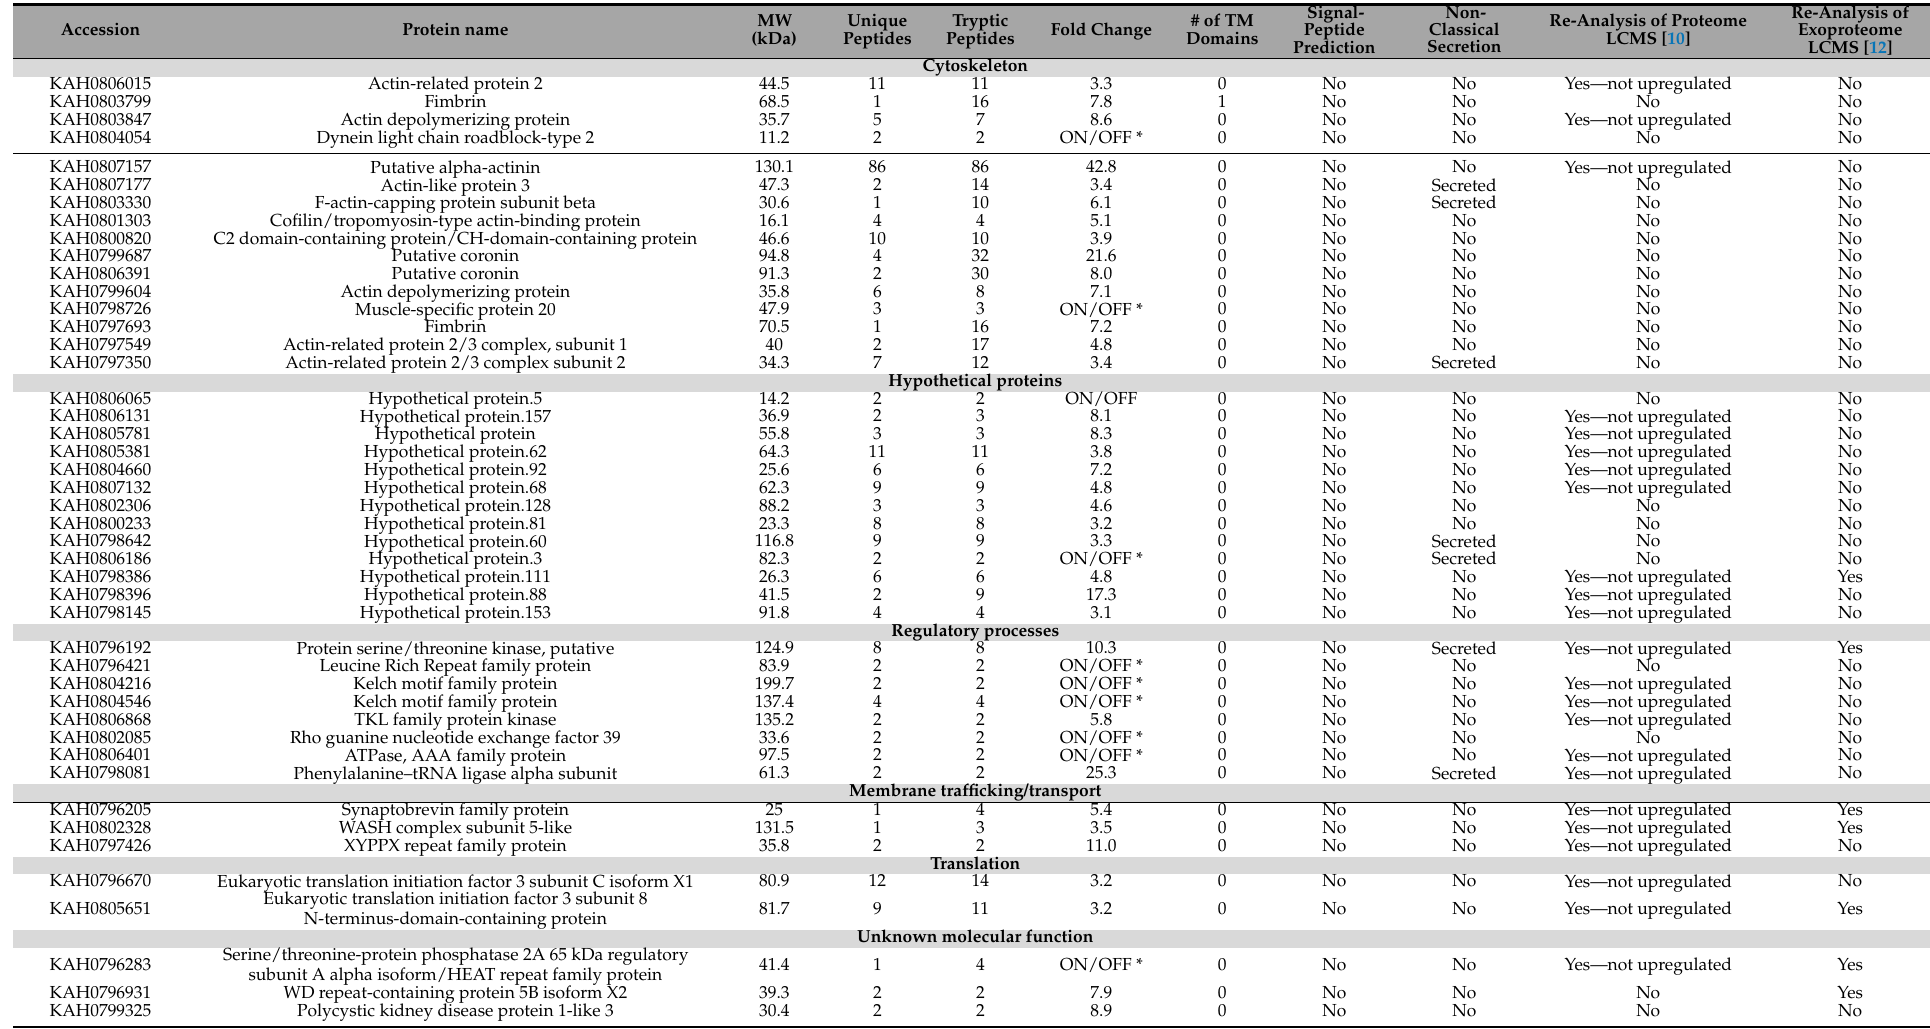
Table 2. List of upregulated proteins identified with LCMS analysis on the surface of the attenuated H. meleagridis